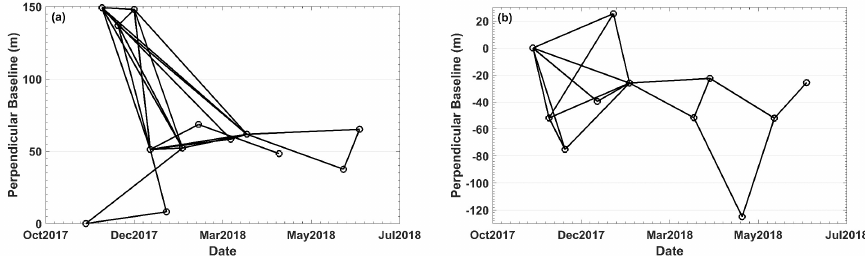
Figure 2. Networks of post-seismic interference pairs from the ( a ) ascending and ( b ) descending tracks. For the multidimensional small baseline subset (MSBAS) analysis, 27 ascending and 18 descending track datasets were used, and the perpendicular baselines of all InSAR pairs were less than 80 m.